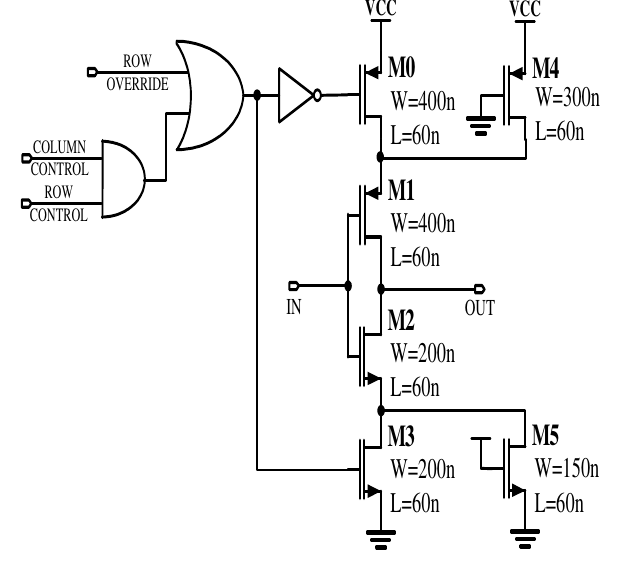
Figure 6. Schematic of the delay cell.